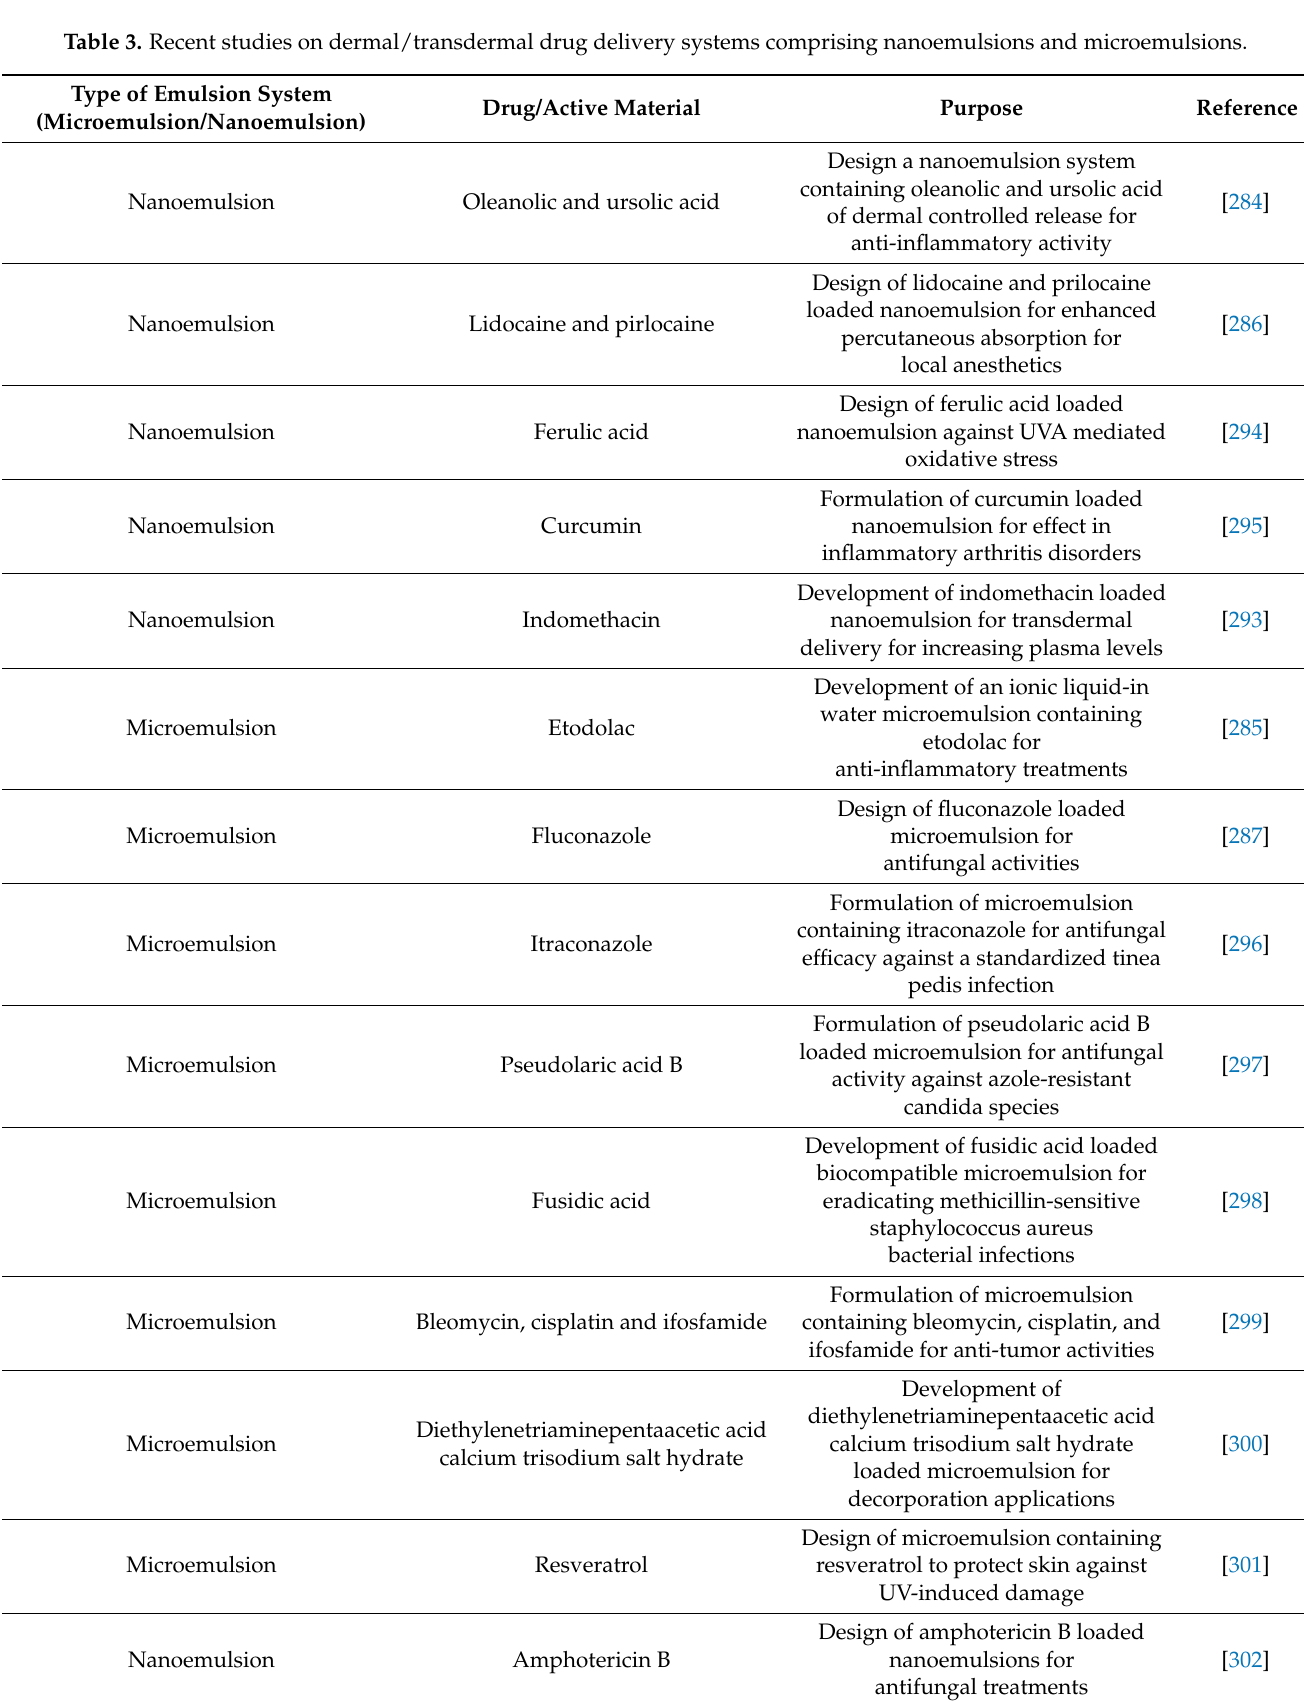
Table 3. Recent studies on dermal/transdermal drug delivery systems comprising nanoemulsions and